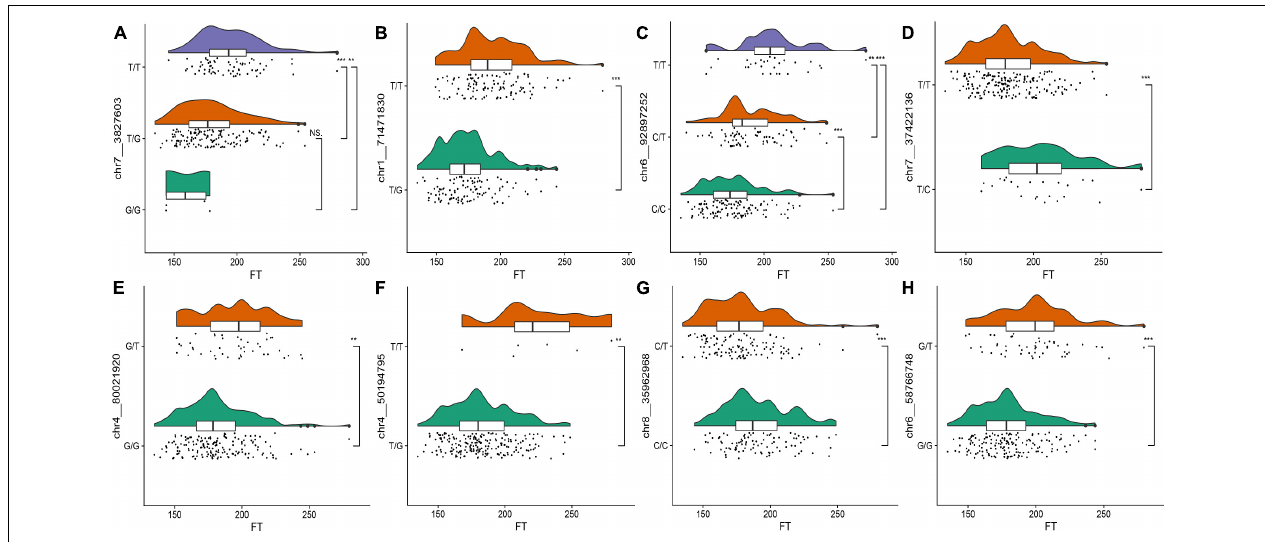
FIGURE 3 | (A–H) Raincloud plots of the highest distribution of the flowering time of the plants with relevant SNP genotypes. The top plots represent the kernel density estimation, the middle plots represent box diagrams, and the bottom plots are dithering scatter diagrams. The different asterisks on the right side of the diagram indicate significant differences at the P < 0.05 level according to Duncan’s multiple comparison test. The abscissa represents flowering time and the ordinate represents SNP genotype.